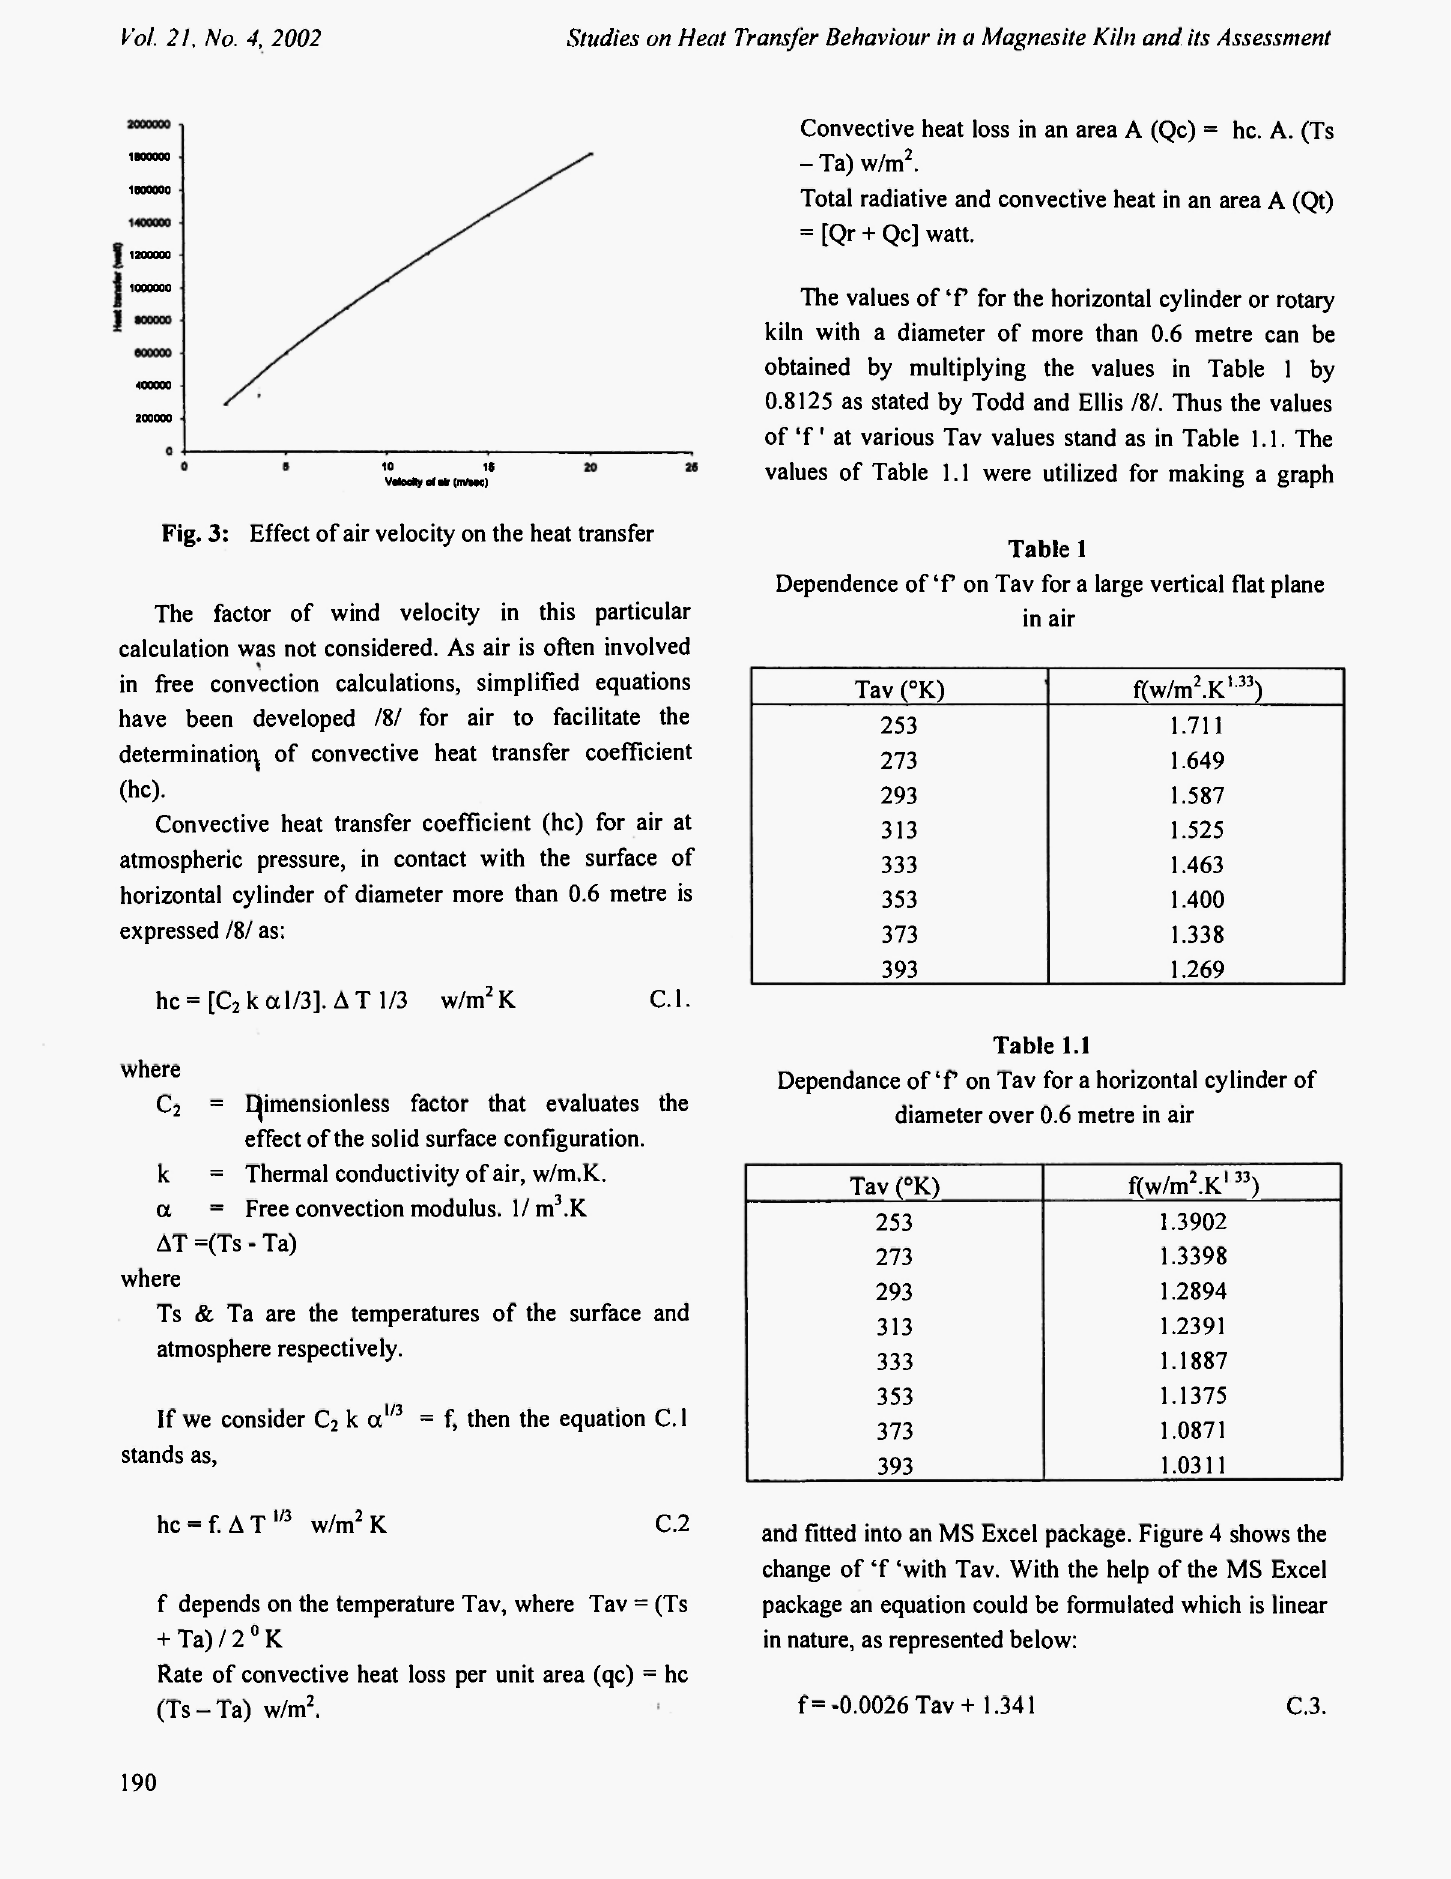
Dependence o f 'f on Tav for a large vertical flat plane in air